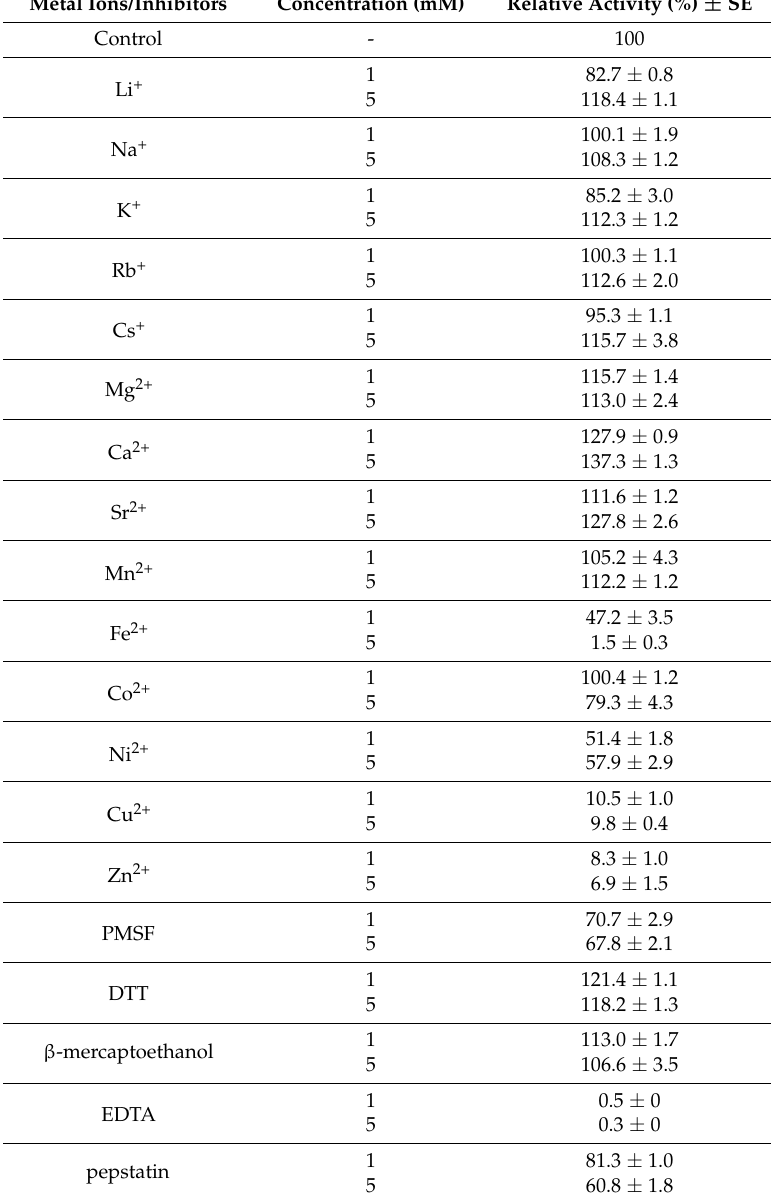
Table 3. Effect of various metal ions and inhibitors on the activity of mature rHZ lipase. Metal